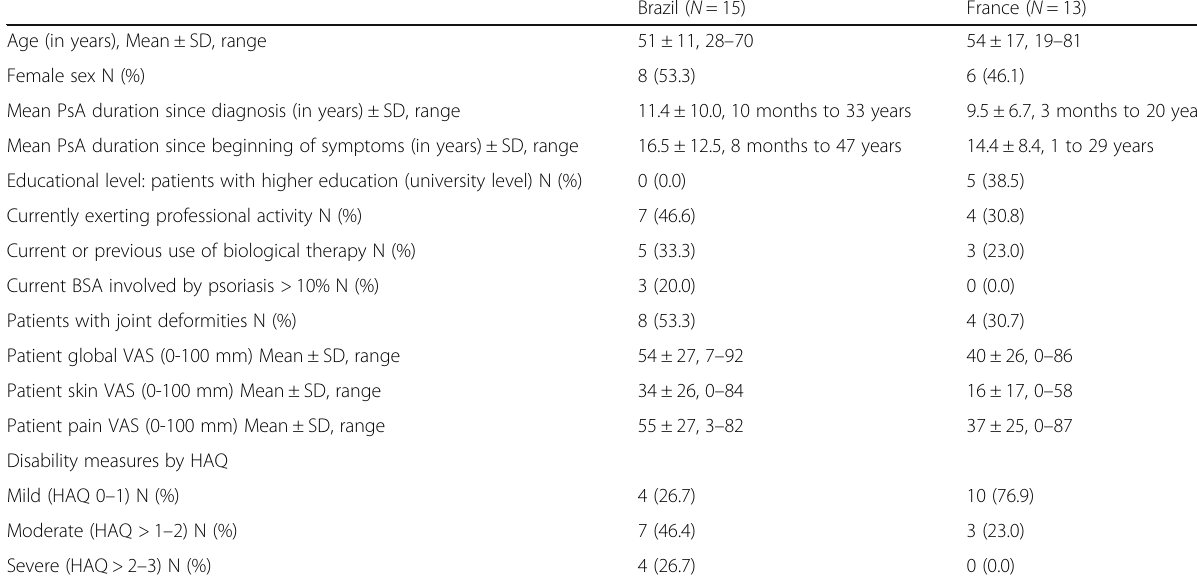
Table 2 Comparison of demographic characteristics and disease activity of patients interviewed in Brazil and France Brazil ( N = 15) France ( N = 13) Age (in years), Mean ± SD, range 51 ± 11, 28 – 70 54 ± 17, 19 – 81 Female sex N (%) 8 (53.3) 6 (46.1) Mean PsA duration since diagnosis (in years) ± SD, range 11.4 ± 10.0, 10 months to 33 years 9.5 ± 6.7, 3 months to 20 years 16.5 ± 12.5, 8 months to 47 years 14.4 ± 8.4, 1 to 29 years